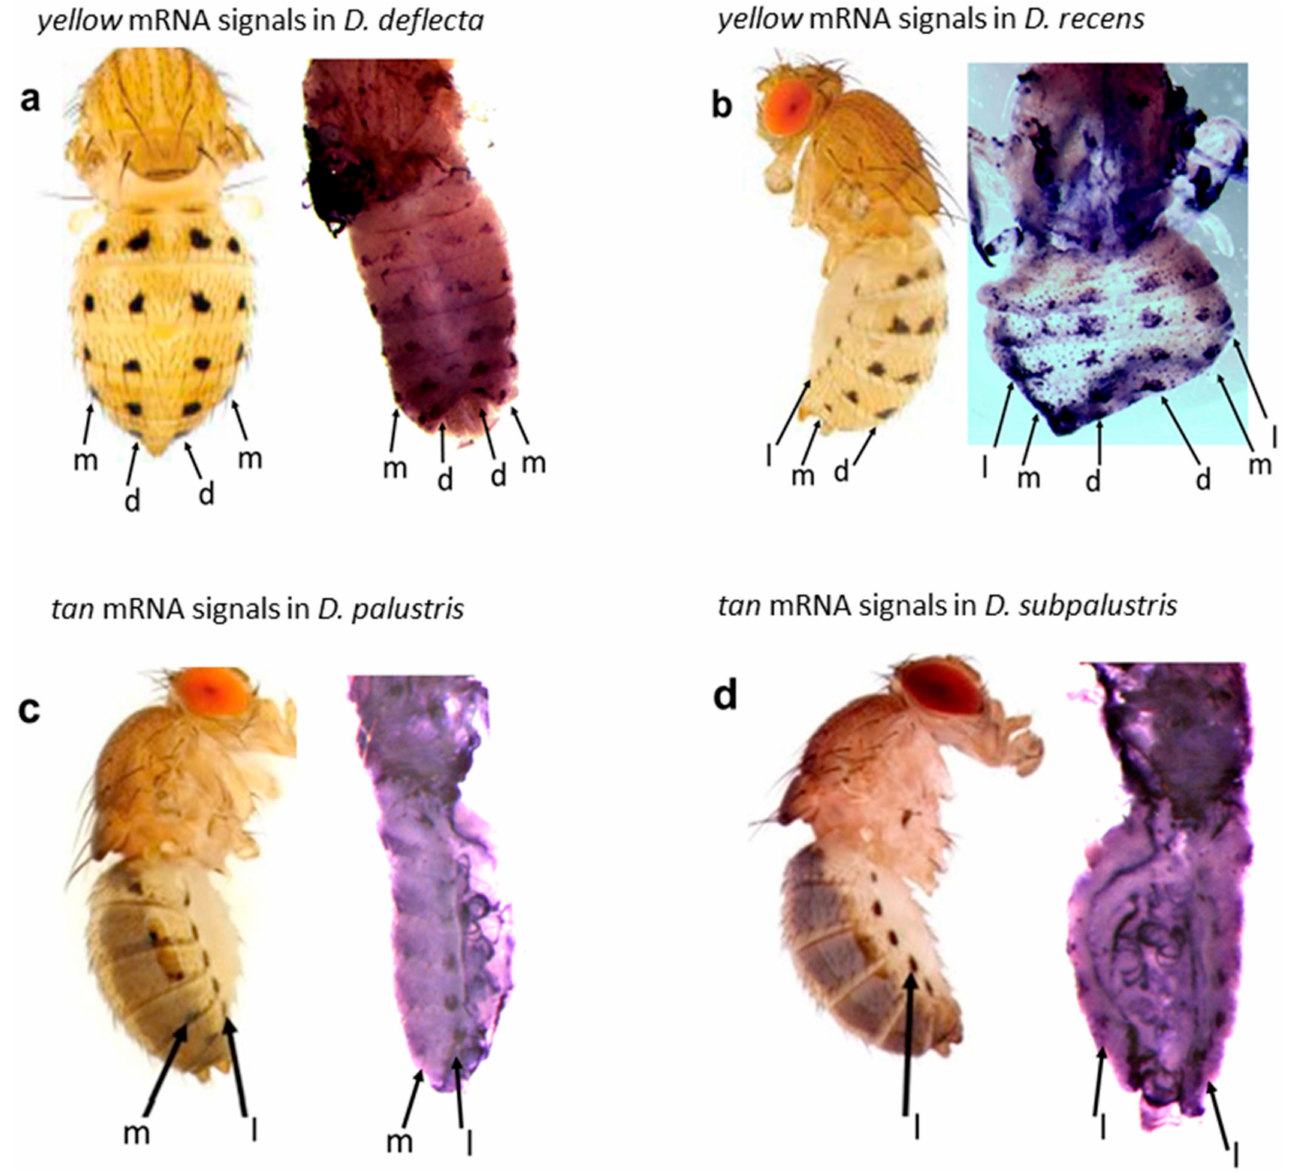
Figure 7. The in situ hybridization signals of the yellow ( y ) and tan ( t ) transcripts during D. deflecta , D. recens , D. palustris , and D. subpalustris pupal development prefigure the adult abdominal spot patterns. The images of the adult flies have been previously published in Werner et al. [23]. ( a , b ) yellow mRNA expression in D. deflecta and D. recens respectively, during pupal stage P10. ( c , d ) tan mRNA expression in D. palustris and D. subpalustris , respectively, during pupal stage P11, as shown in Dion et al.